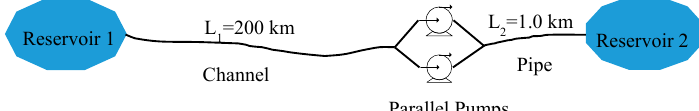
Figure 7. Notation for open channel and pipe combined system. Table 3. Computation parameters.